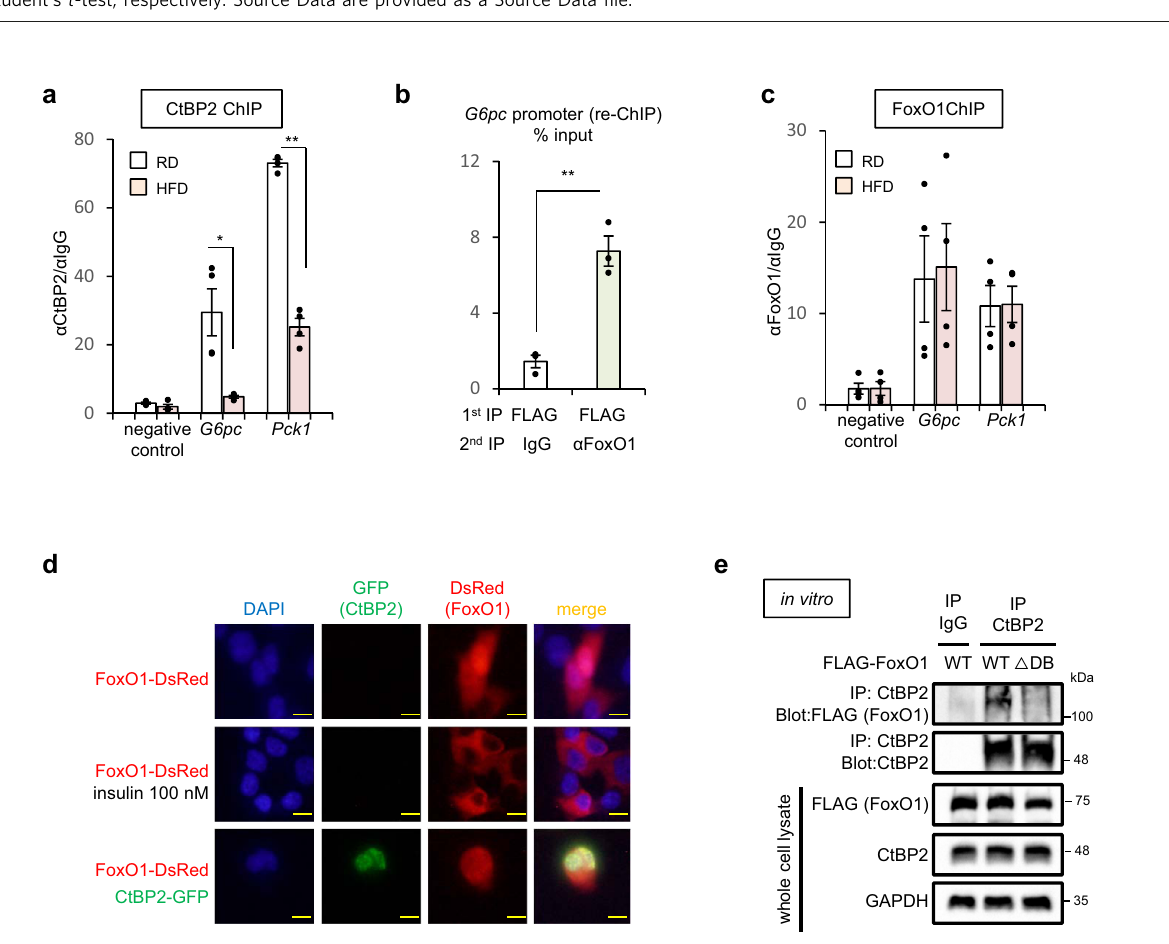
Fig. 4 Dissociation of CtBP2 from FoxO1 occurs in the nucleus. a CtBP2 recruitment to promoter regions of gluconeogenic genes ( n = 4, biologically independent animals, p values are as follows: 0.011 for G6pc and 2.4 × 10 − 6 for Pck1 ). HFD diet-induced obese mice. b Sequential ChIP (re-ChIP) in primary hepatocytes. FLAG-CtBP2 and FoxO1 were exogenously expressed, the chromatin was fi rst enriched by FLAG (CtBP2) immunoprecipitation and the eluents were further immunoprecipitated with either control IgG or anti-FoxO1 antibody ( n = 3, biologically independent cells, p = 2.5 × 10 − 3 ). c FoxO1 recruitment to promoter regions of gluconeogenic genes ( n = 4, biologically independent animals). Liver tissues were collected following a 6-h fast ( a , c ). d FoxO1- DsRed and/or CtBP2-GFP were expressed in hepa1-6 cells and treated with vehicle or 100 nM insulin for 30 min. The yellow bars indicate 10 μ m. e The forced cytoplasmic localization of FoxO1 markedly diminishes CtBP2/FoxO1 interaction. Either the wild-type FoxO1 (WT) or the mutant FoxO1 ( △ DB) was exogenously expressed in HEK293 cells, and the CtBP2/FoxO1 complex was co-immunoprecipitated. Data are expressed as the mean ± SEM. * and ** denote p < 0.05 and p < 0.01 evaluated by unpaired two-tailed Student ’ s t -test, respectively. Source Data are provided as a Source Data fi obese mice in vivo (Supplementary Fig. 7a). Replenishment of mice . Since CtBP2 activation in hepatocytes downregulated glu- without inducing any changes in body weights (Fig. 6a and coneogenic and lipogenic gene expression in vitro (Figs. 1f and 3j) and the activity of CtBP2 is diminished in obesity (Fig. 3e – i and Supplementary Fig. 4f), we investigated whether exogenous sup- plementation of CtBP2 can improve the metabolic pro fi le of